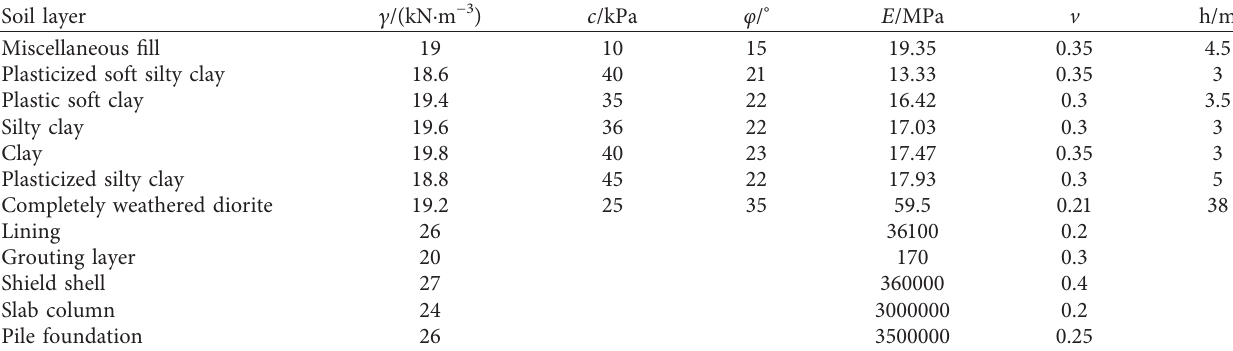
Table 1: The main material parameters of the